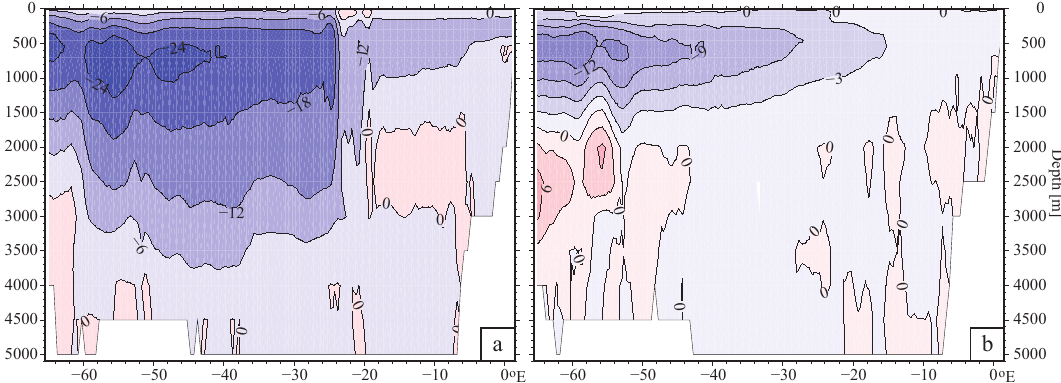
Fig. 10. Overturning. Zonal overturning in the North Atlantic Basin for the SATL experiment (left) and the LOWSL-TET experiment (right). Contour lines are drawn every 3Sv, blue colours indicate negative (counterclockwise) overturning and red colours positive